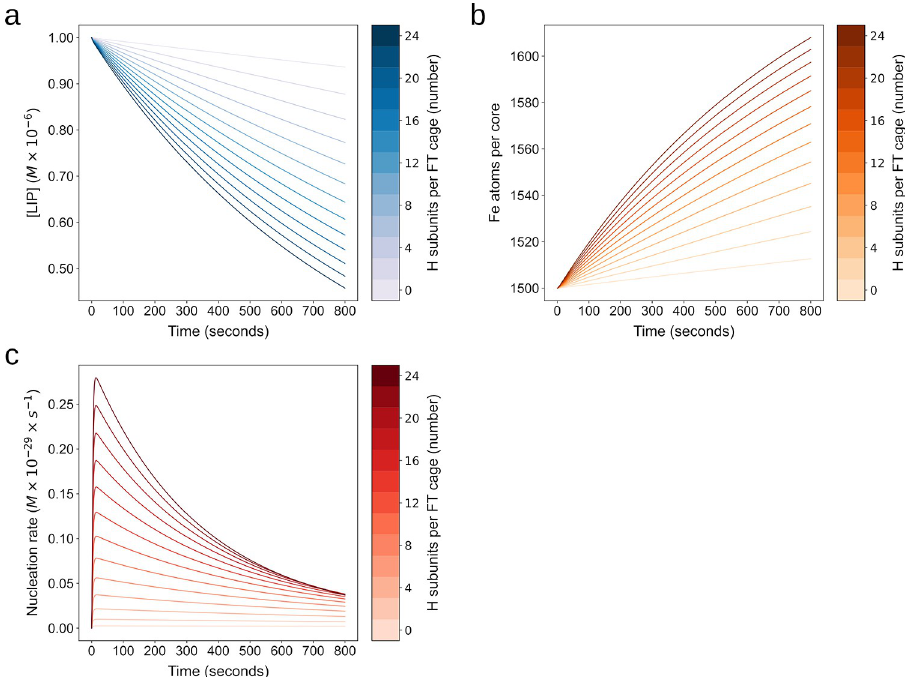
Fig 7. Subunit composition effect on FT iron sequestration dynamics. The model contains a parameter H that can be varied to incorporate differences in subunit composition of a population of FT-cages versus another and the effect of the composition on the rate laws of oxidation and nucleation. H represents the number of H subunits and can be between 0 (L homopolymer) and 24 (H homopolymer). We ran 13 simulations with the number of H subunits in the FT cages increasing from 0 to 24 in increments of 2. Then iron sequestration behavior was assessed by tracking a) LIP b) APC and c) nucleation rate over time.